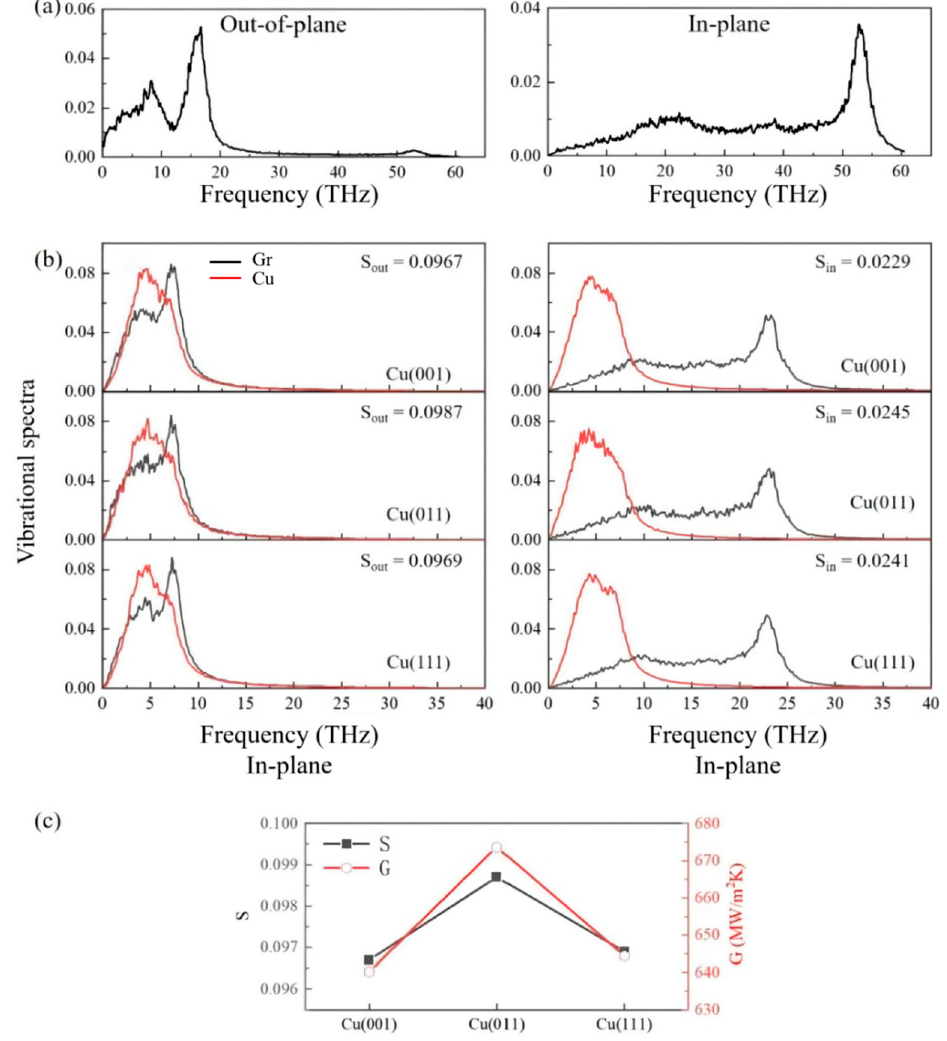
Figure 4. ( a ) Phonon spectra of single graphene at 300 K. ( b ) Out-of-plane and in-plane vibrational spectra of different surfaces. ( c ) The overlap parameter S of the VDOS and corresponding TBC with distinct surfaces.